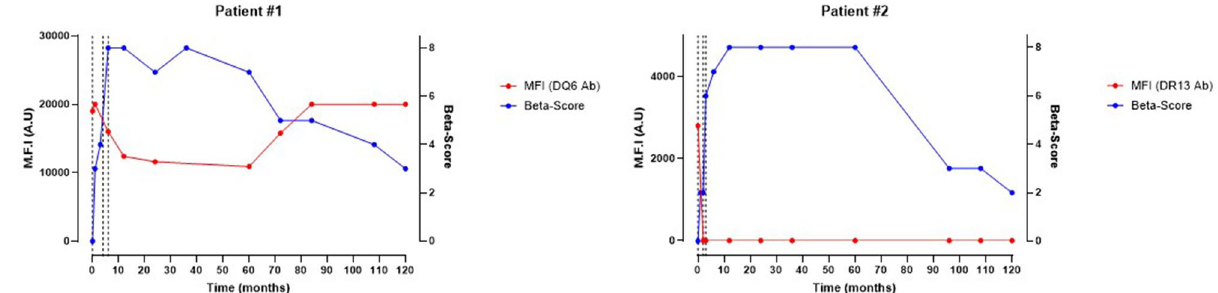
Figure 3. Evolution of β-Score over time in type 1 diabetic pancreatic islet recipients presenting with high or low preformed Donor Specific Antibodies. Patient#1 (left panel) presented with high-MFI preformed DSA targeting every islet transplantation. Patient#2 (right panel) presented with a low-MFI preformed DSA targeting two islet donors (only one presented). Vertical dash lines represent every pancreatic islet injection. Ab Antibody; MFI Mean-Fluorescence